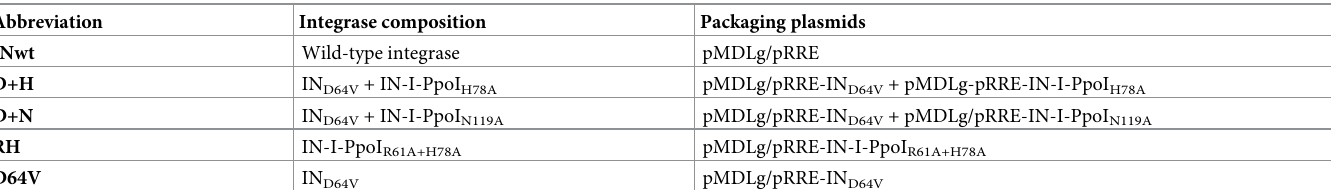
Table 1. The types of LVs, their integrase composition and packaging plasmids used in this